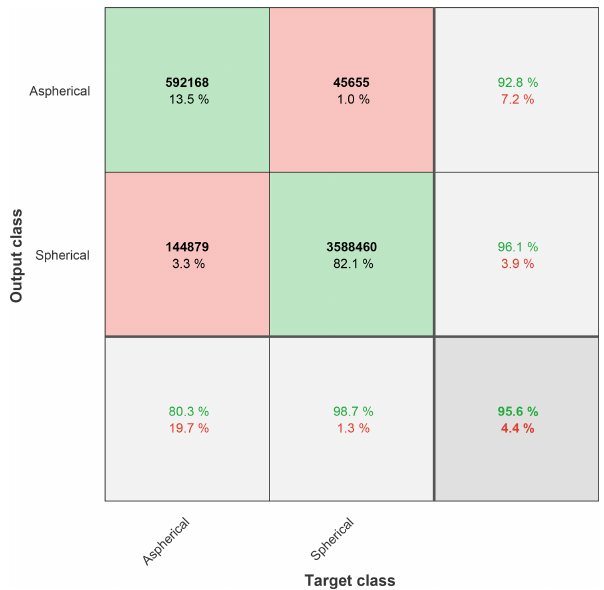
Figure 6. Confusion matrix of the random forest model applied to test data, i.e., the fraction of particles not used for model training, encompassing both spherical and aspherical particles of diameters between approximately 3 and 32µm. The random forest model was trained using four predictor variables and 200 trees. The confusion matrix shows the true (i.e., target) class (columns) of the particles versus the predicted (i.e., output) class (rows). Colored cells : in each cell, the number of particles and percentage from total is given. Pre- cision : the light gray column on the right-hand side indicates per- centages of all the particles predicted to belong to each class that are correctly (green, true discovery) and incorrectly (red, false dis- covery) predicted. Per-class accuracy : the light gray cells on the bottom row give the percentages of all particles belonging to each class that are correctly (green, true positives) and incorrectly (red, false negatives) classified. Overall accuracy : values shown in the bottom right cell give overall model accuracy, i.e., the fraction of particles correctly (green) and incorrectly (red) predicted out of all particles classified by the